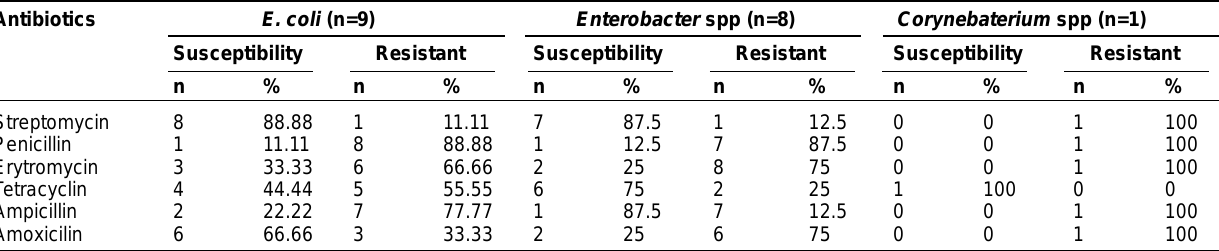
Table-1(a): Antibiotic susceptibility of bacterial isolates (